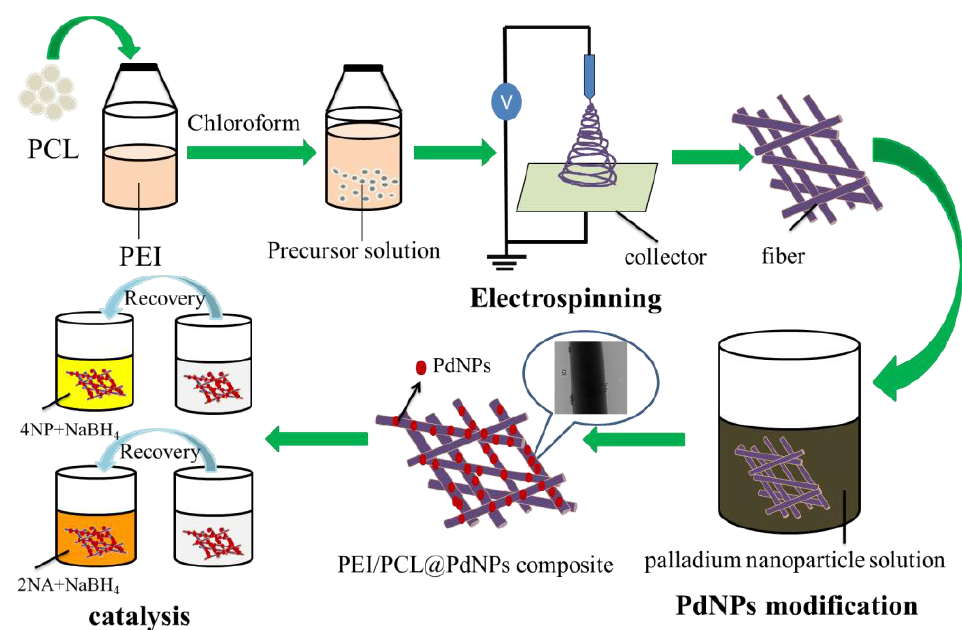
Figure 1. Preparation process of polyethyleneimine/polycaprolactone/Pd nanoparticles (PEI/PCL@PdNPs) composite and its catalytic performance.